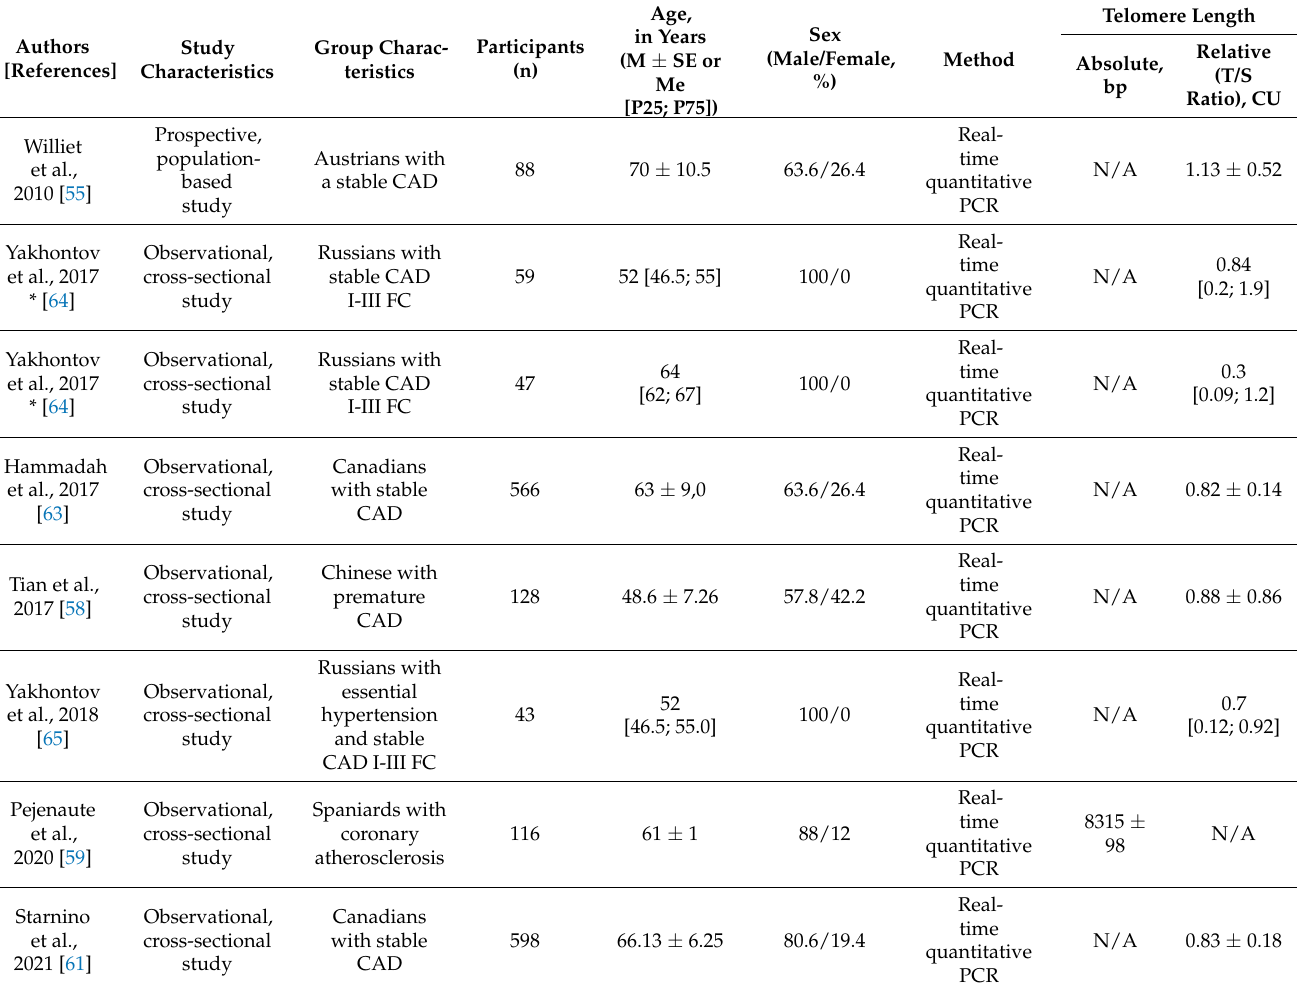
Table 2. Mean Relative Telomere Length of Leukocytes in Adults with Stable Coronary Artery